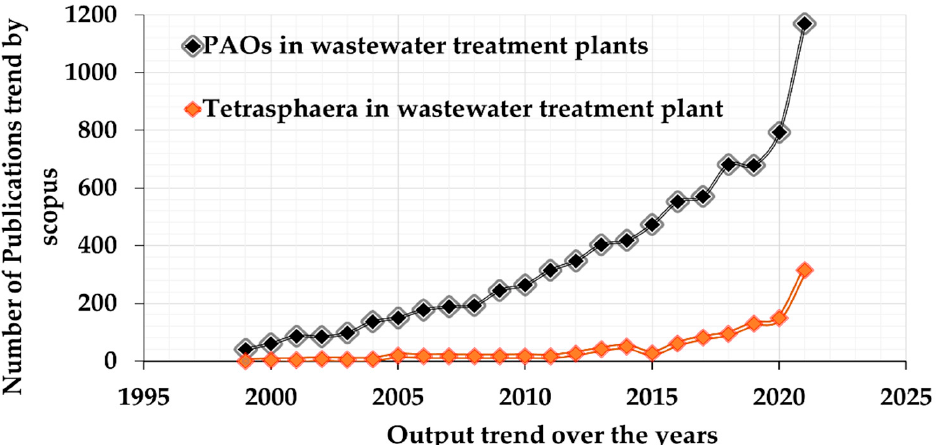
Figure 4. Comparison of PAO and Tetrasphaera mentions in publications related to EBPR.